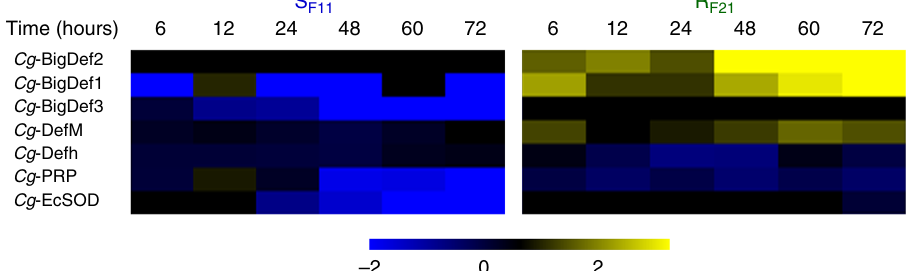
Fig. 8 Antimicrobial peptides and Cg -EcSOD expression is repressed in the susceptible S F11 oysters. Time-course of antimicrobial peptide (AMP) and Cg - EcSOD expression in S F11 and R F21 oysters during the ‘ natural ’ experimental infection. The relative expression of AMPs was analysed by comparing the number of reads (calculated by alignment using DIAMOND 0.7.9) between each time point and time zero. Analyses were performed using the RNA-seq data by mapping against the C . gigas genome for Cg -EcSOD. The intensity of the colour from blue to yellow indicates the magnitude of the differential expression (log2 fold change). The heatmap was constructed with Multiple Array Viewer